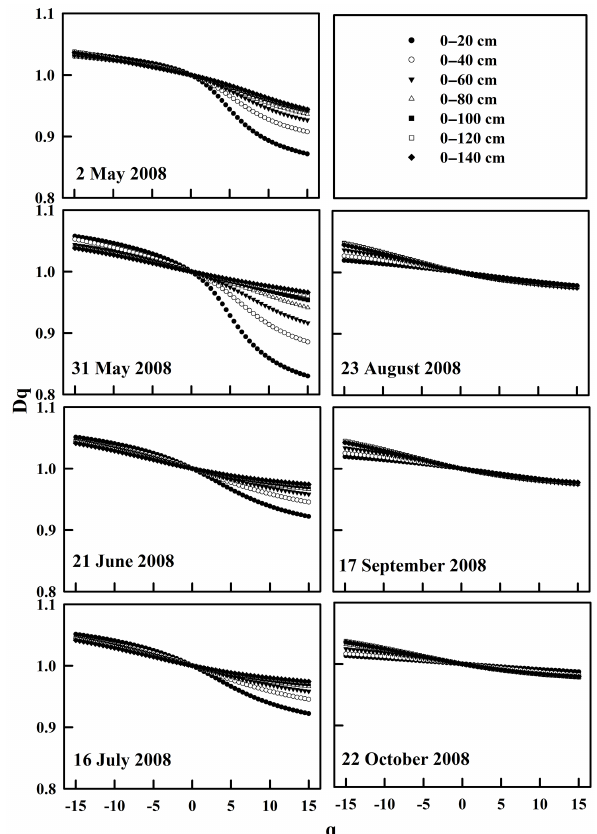
Figure 10. Generalized dimension spectra of soil water storage spa- tial series from surface to different soil layers (cumulative storage) at 20cm increment down to 140cm in 2008 for a range of q ( − 15 to 15 at 0.5 increments).